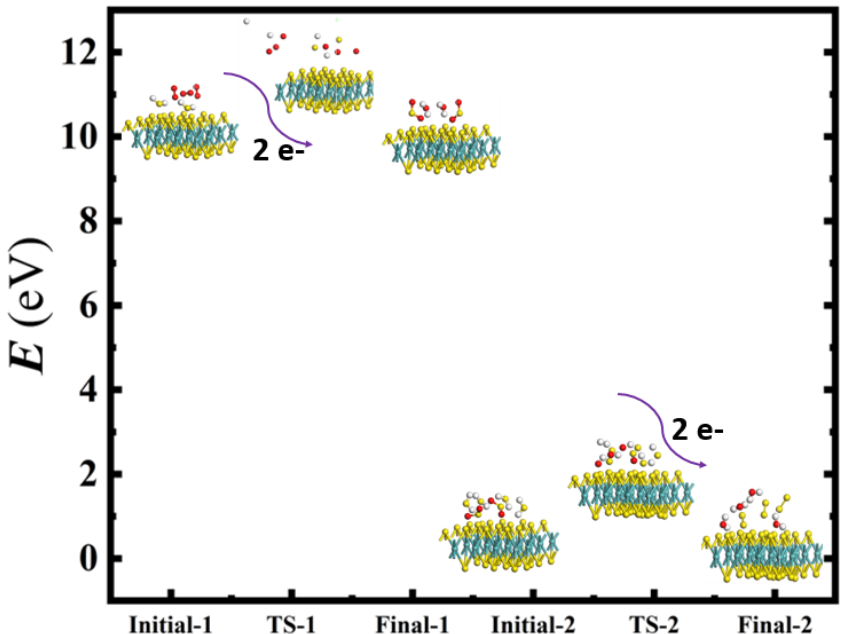
Figure 7. Calculated initial, transition, and final states for geometrically optimized doubly-charged negative AA stacked MoS 2 catalyzing the oxidation–reduction of sulfur dioxide to elemental sulfur. The Mo, S, O, and H atoms are represented by cyan, yellow, red, and white spheres, respectively. The curved arrows demonstrate the introduction of two electrons into the reactant states, causing bond breakage in the predicted transition states of step 1 and step 2, which describes the doubly-charged catalytic process used for our calculations.